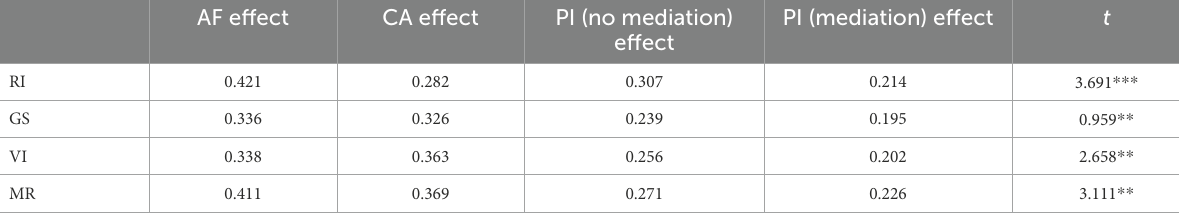
TABLE 10 Partial mediation effect and complete mediation effect test